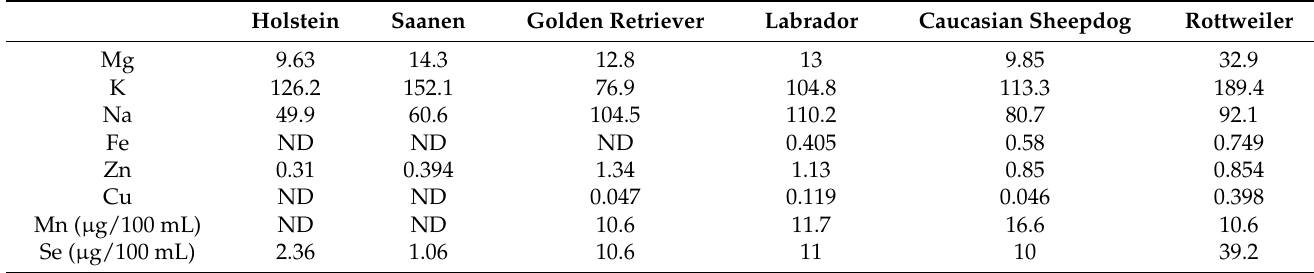
Table 4. The mineral contents of canine, bovine, and caprine milk (mg/100